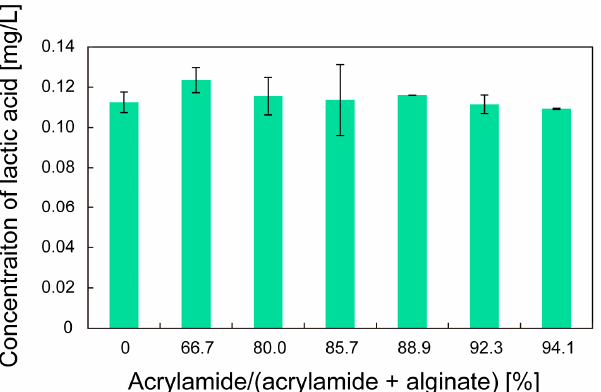
Figure 9. Concentration of the lactic acid produced by C. glutamicum as a function of the composition ratio of acrylamide and alginate after cultivation for 3 h.